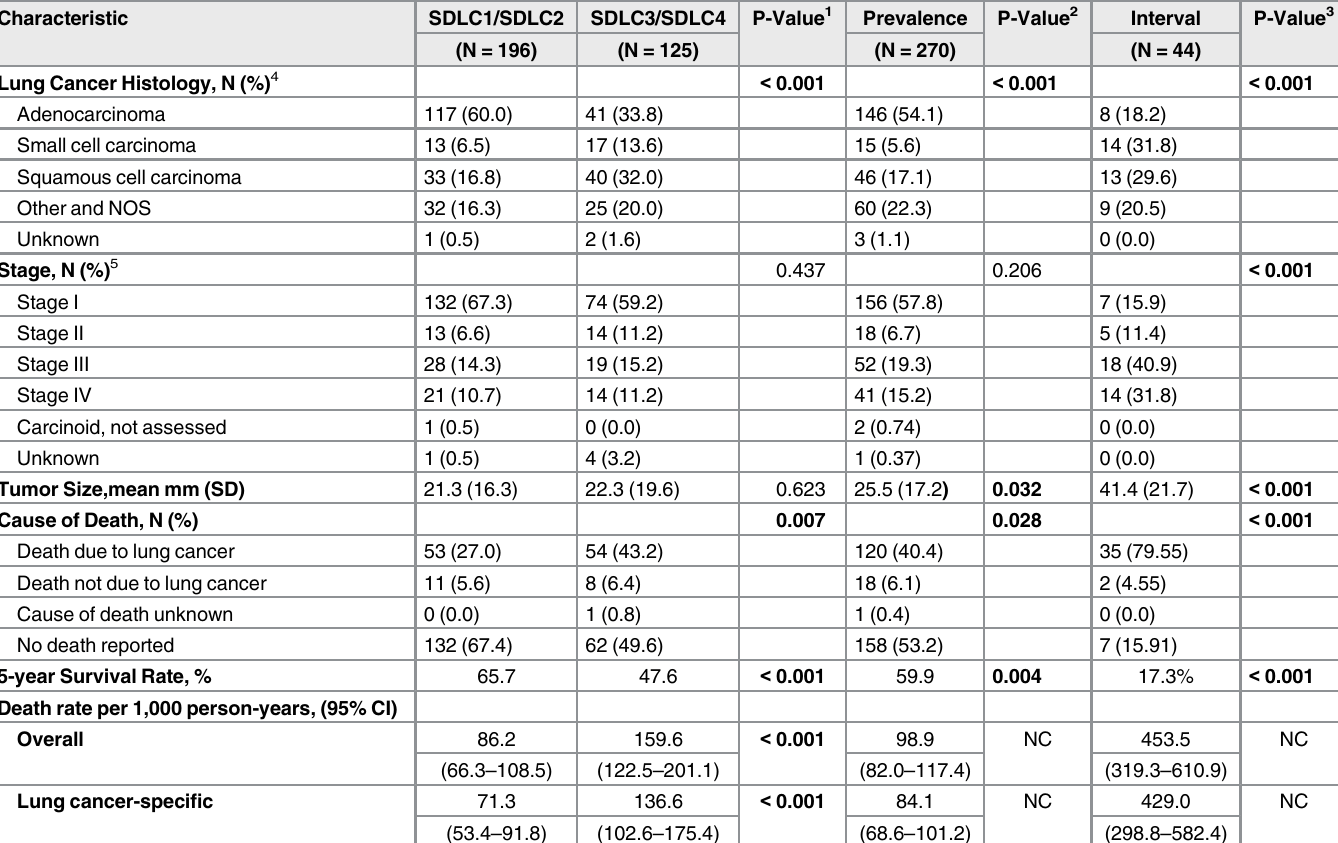
Table 3. Clinical Characteristics and Outcomes of the Grouped Screen-Detected, Prevalence, and Interval Cancer Cohorts.